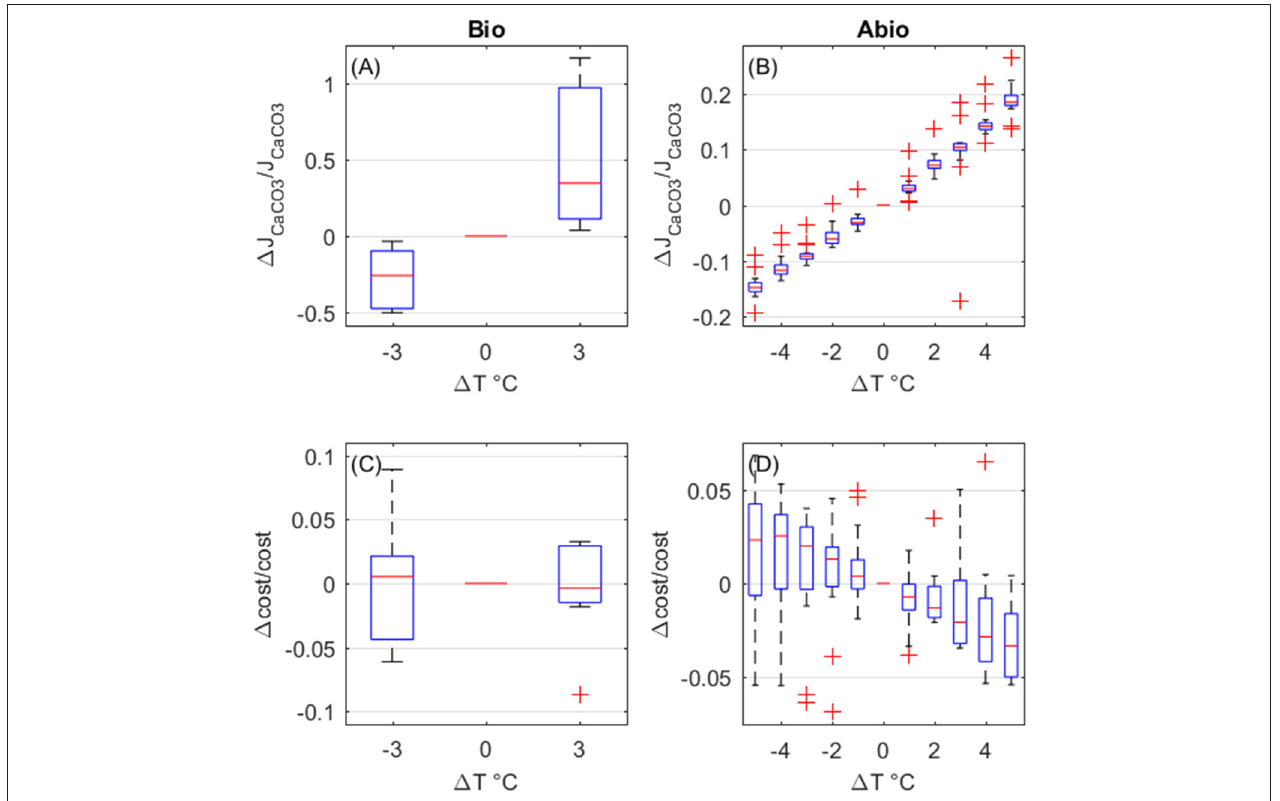
FIGURE 8 | Biologically-mediated (A,C) and abiotic (B,D) effects of temperature, fractional change in calcification rates (top panels) and calcification costs (bottom panels). Y-axis values are indicative of fractional change. Each boxplot represents all